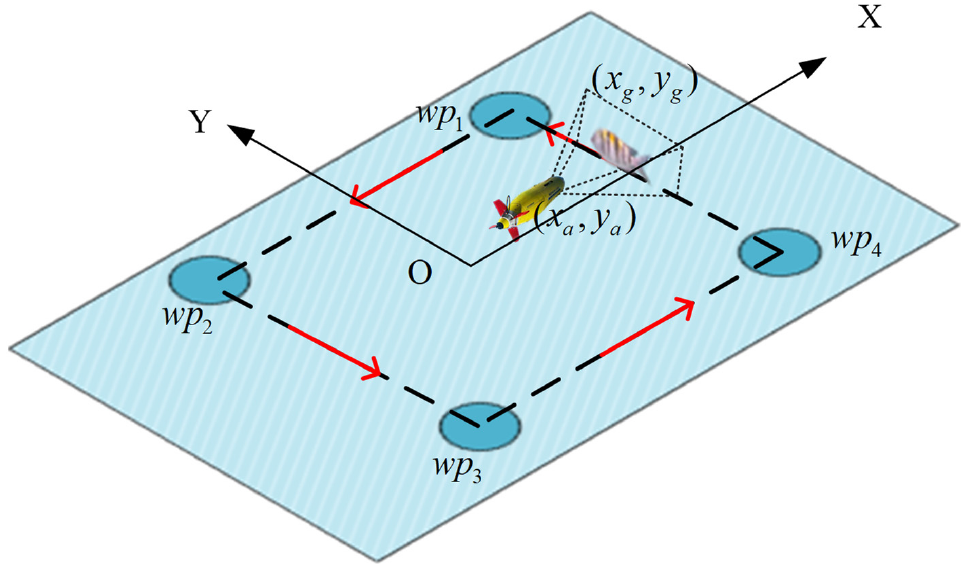
Figure 2. AUV tracking target diagram.